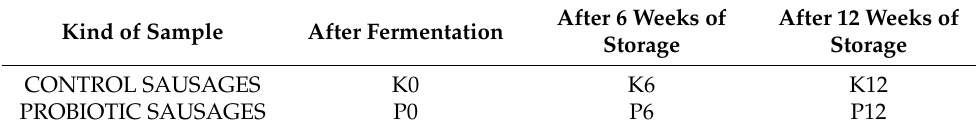
After 6 Weeks of After 12 Weeks of Storage Storage